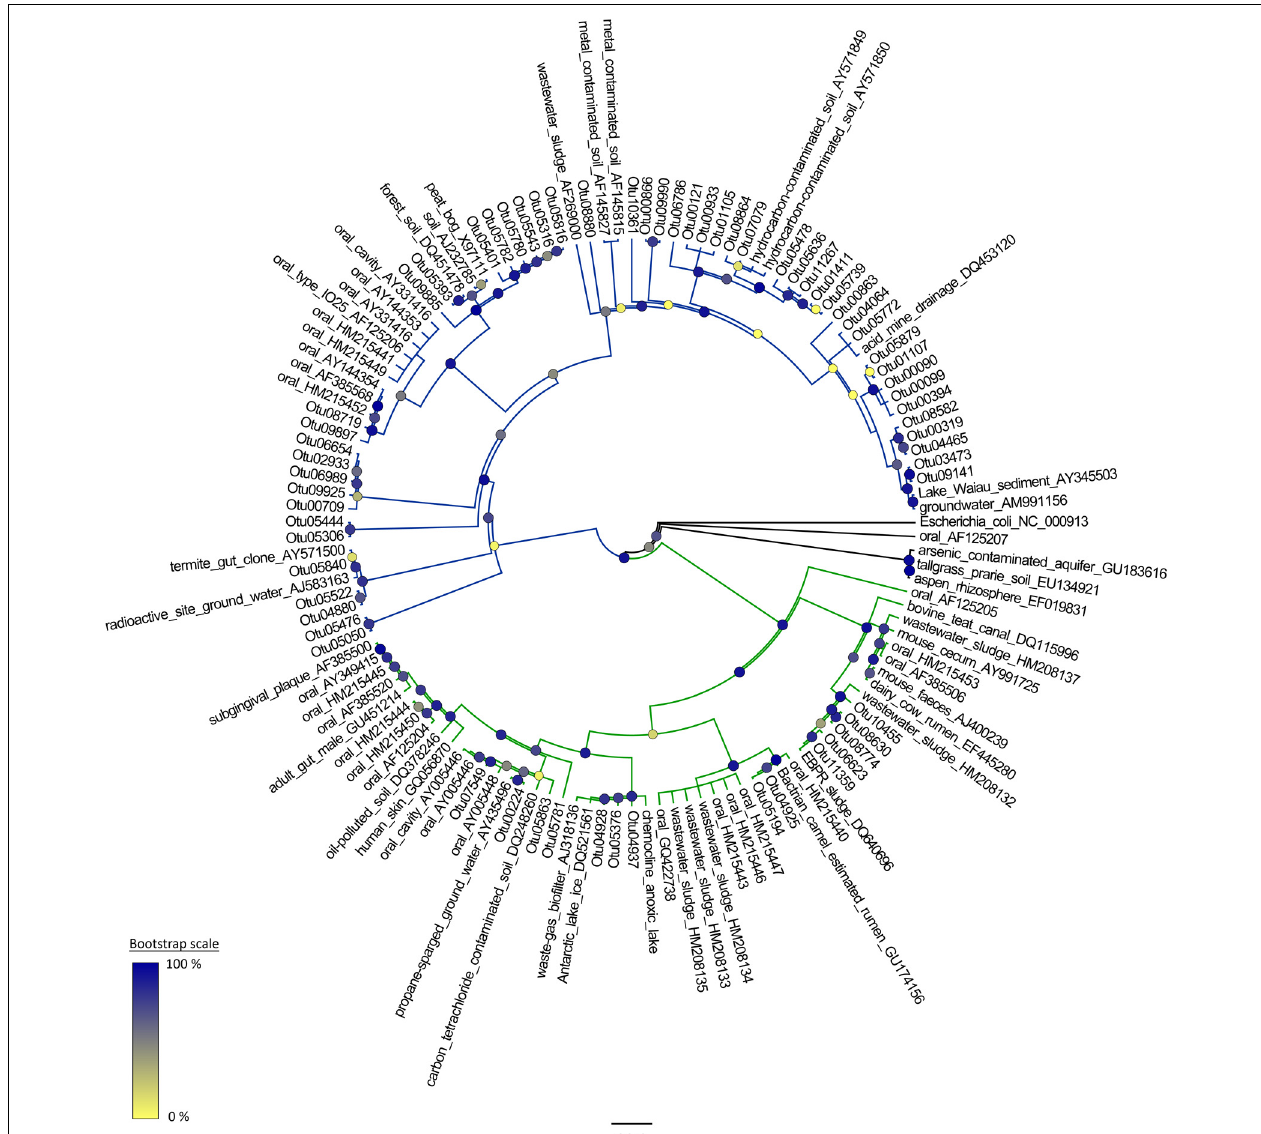
FIGURE 1 | A phylogenetic reconstruction of the candidate division TM7. The reference sequences are obtained from GreenGenes. The tree is a maximum-likelihood phylogeny generated in FastTree 2 with